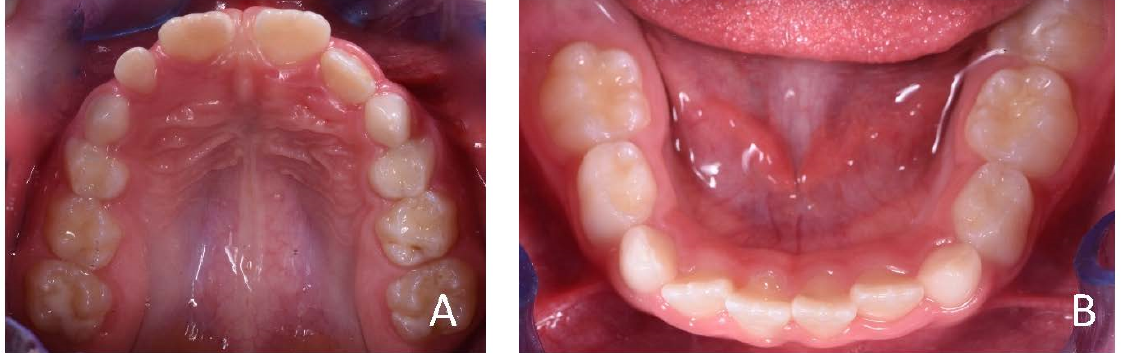
Figure 22. Initial occlusal photos of dental arches (7-year-old). ( A ) Upper arch; ( B ) lower arch.